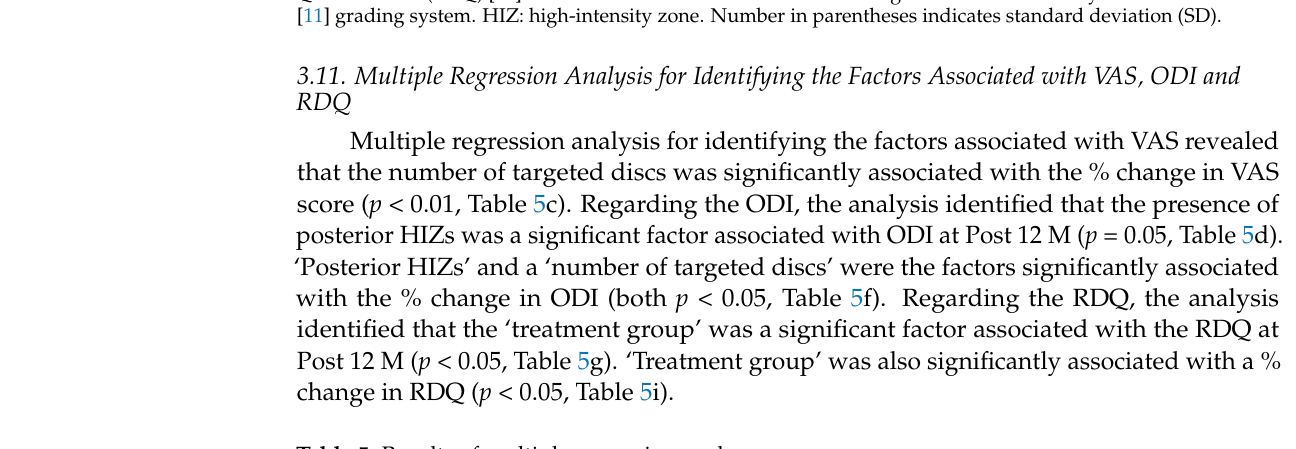
Table 5. Results of multiple regression